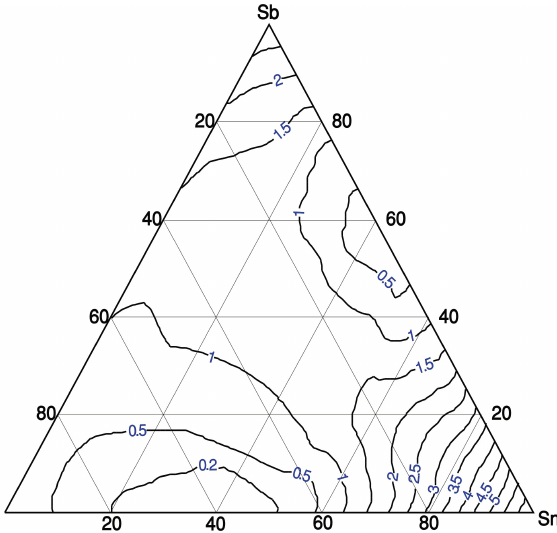
Figure 4. Isolines of electrical conductivity of the ternary Bi-Sb-Sn